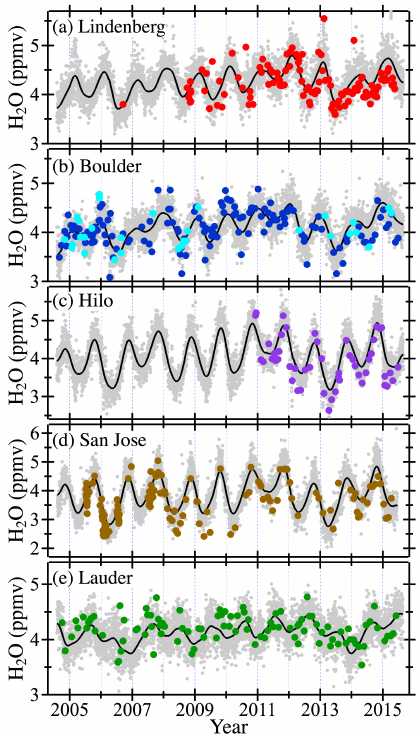
Figure 1. Daily average MLS version 3.3 overpass retrievals (gray markers, smoothed black curves) and in situ frost point hygrometer (FP) data at 68hPa for individual soundings at each site (filled cir- cles). Data from two types of FPs are shown: NOAA FPH at Boul- der (dark blue), Hilo and Lauder, and CFH at Lindenberg, Boulder (cyan) and San Jose. Note the emerging biases between FP and MLS mixing ratios at all five sites towards the ends of their